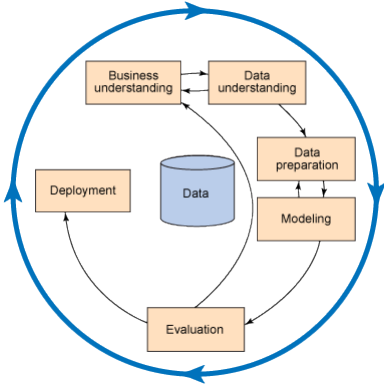
Figure 2. The basic schema of